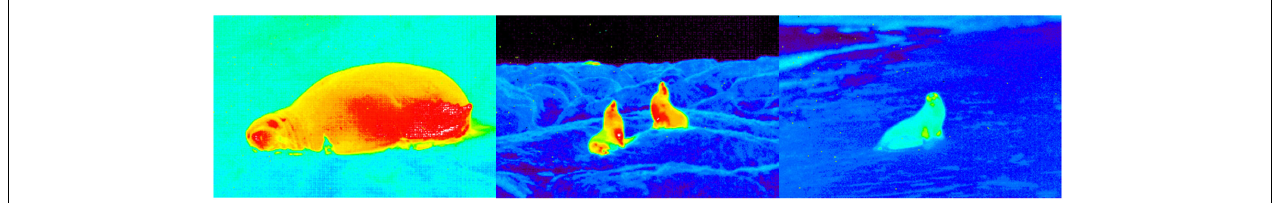
FIGURE 11 | Infrared thermographic images of Australian sea lions, Neophoca cinerea, on Kangaroo Island, South Australia where areas with warmer colors indicate higher temperatures and thus greater heat loss. Left image, a female sea lion hauled out on the beach. The greatest heat loss is through the eyes, nose and flippers. Middle image, two sea lions appear considerably warmer than the surrounding habitat. Notice that the flippers are significant thermal windows. Right image, a female sea lion is just coming out of the water. Although the animal has significantly lower heat loss than the previous two images where the animals had been out of the water for some time, the female is still losing some heat from the eyes and the base of the fore flippers. Photos by Heather